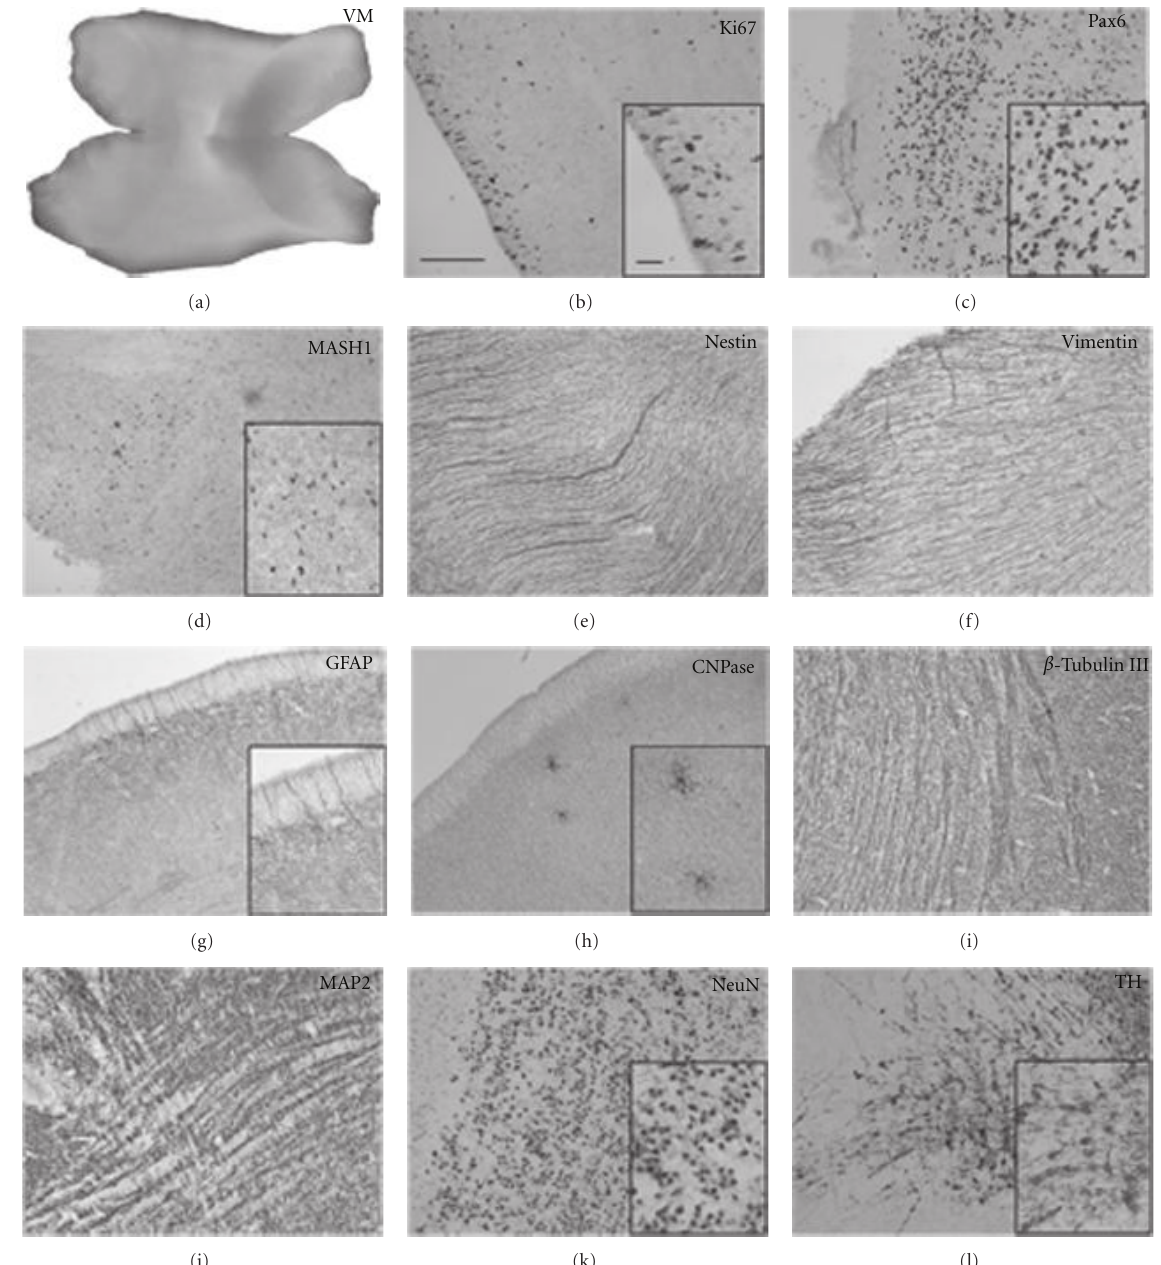
Figure 4: Expression of stem cell markers and markers of glial and neuronal cells in primary (noncultured) porcine ventral mesencephalon (VM) obtained at embryonic day 28–30. Photomicrographs showing an intact VM (a), and immunoexpression of the proliferation marker Ki67 (b), the proneural markers Pax6 (c) and MASH1 (d), the neural stem cell marker nestin (e), the glial markers vimentin (f) and GFAP (g), the oligodendrocyte marker CNPase (h), the neuronal markers β Tubulin III (i), MAP2 (j) and NeuN (k), and the dopaminergic marker TH (l). Scale bars: 100 μ m (overview) and 20 μ m